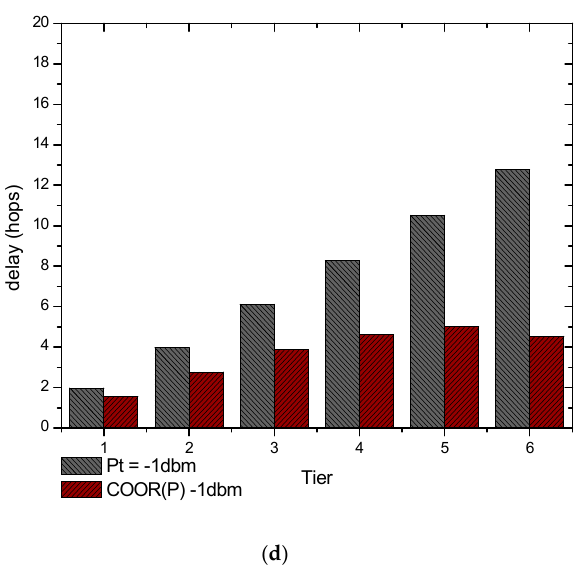
Figure 20. ( a ) Delay of different region under r = 60, N = 2; ( b ) Delay of different region under r = 70, N = 3; ( c ) Delay of different region under r = 80, N = 4; ( d ) Delay of different region under r = 90, N = 4.